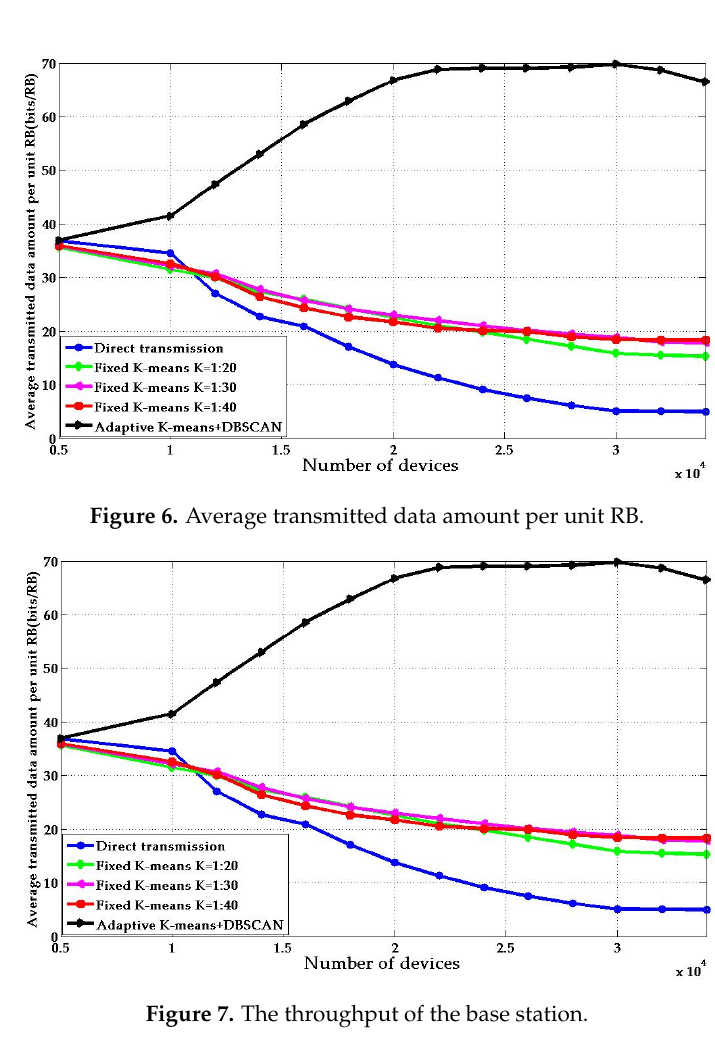
Figure 4. Access success probability. Figure 5. Average number of Resource Block (RB)s used per unit of time.